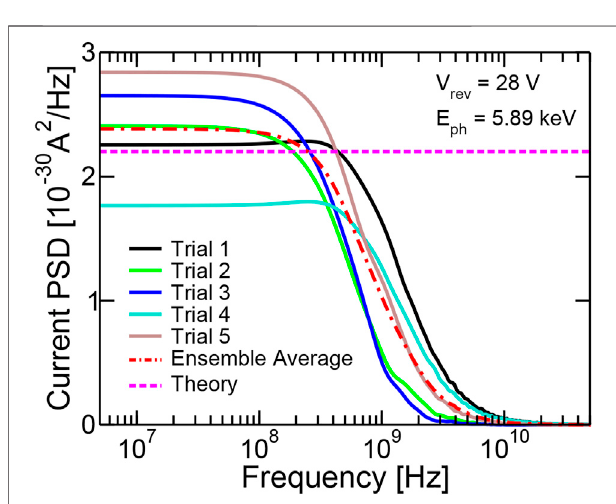
FIGURE 13 | Power spectral density of the waveforms in Figure 12 computed using Eq. 32 . They are normalized to a photon absorption rate Λ = 1 Hz. The theoretical value of the low frequency value from Eq. 34 is reported by the dashed line.